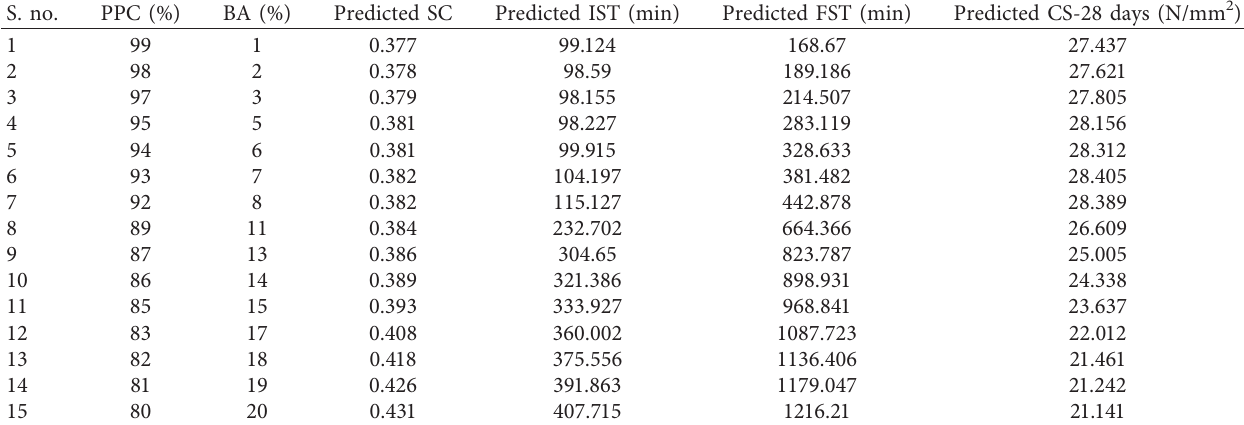
Table 6: Intermediate mix proposition of BA with PPC-test dataset for ANN1.